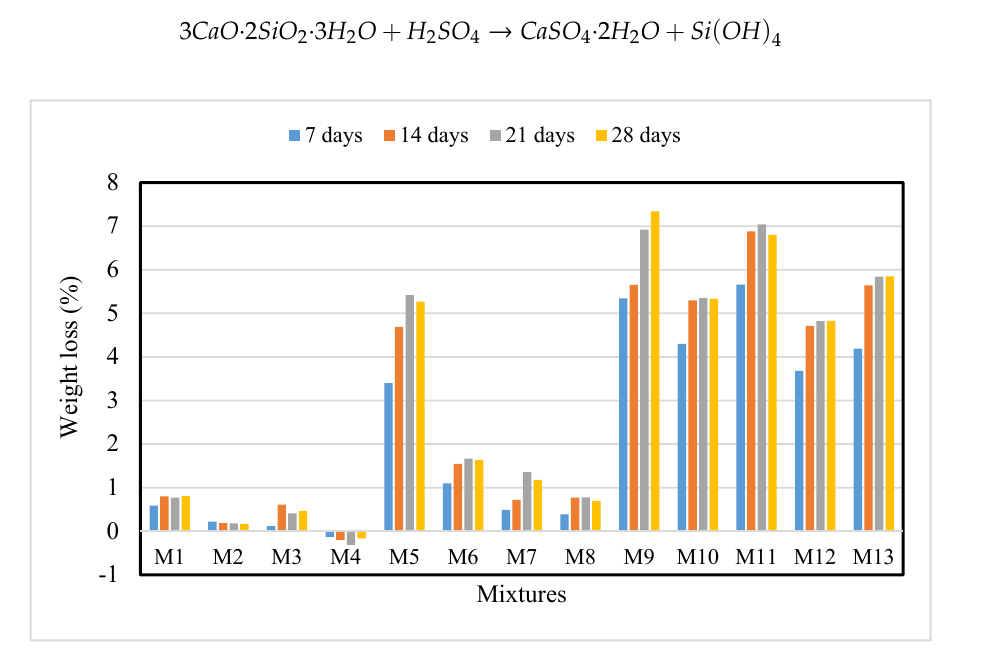
Figure 8. Weight loss vs. exposure time.